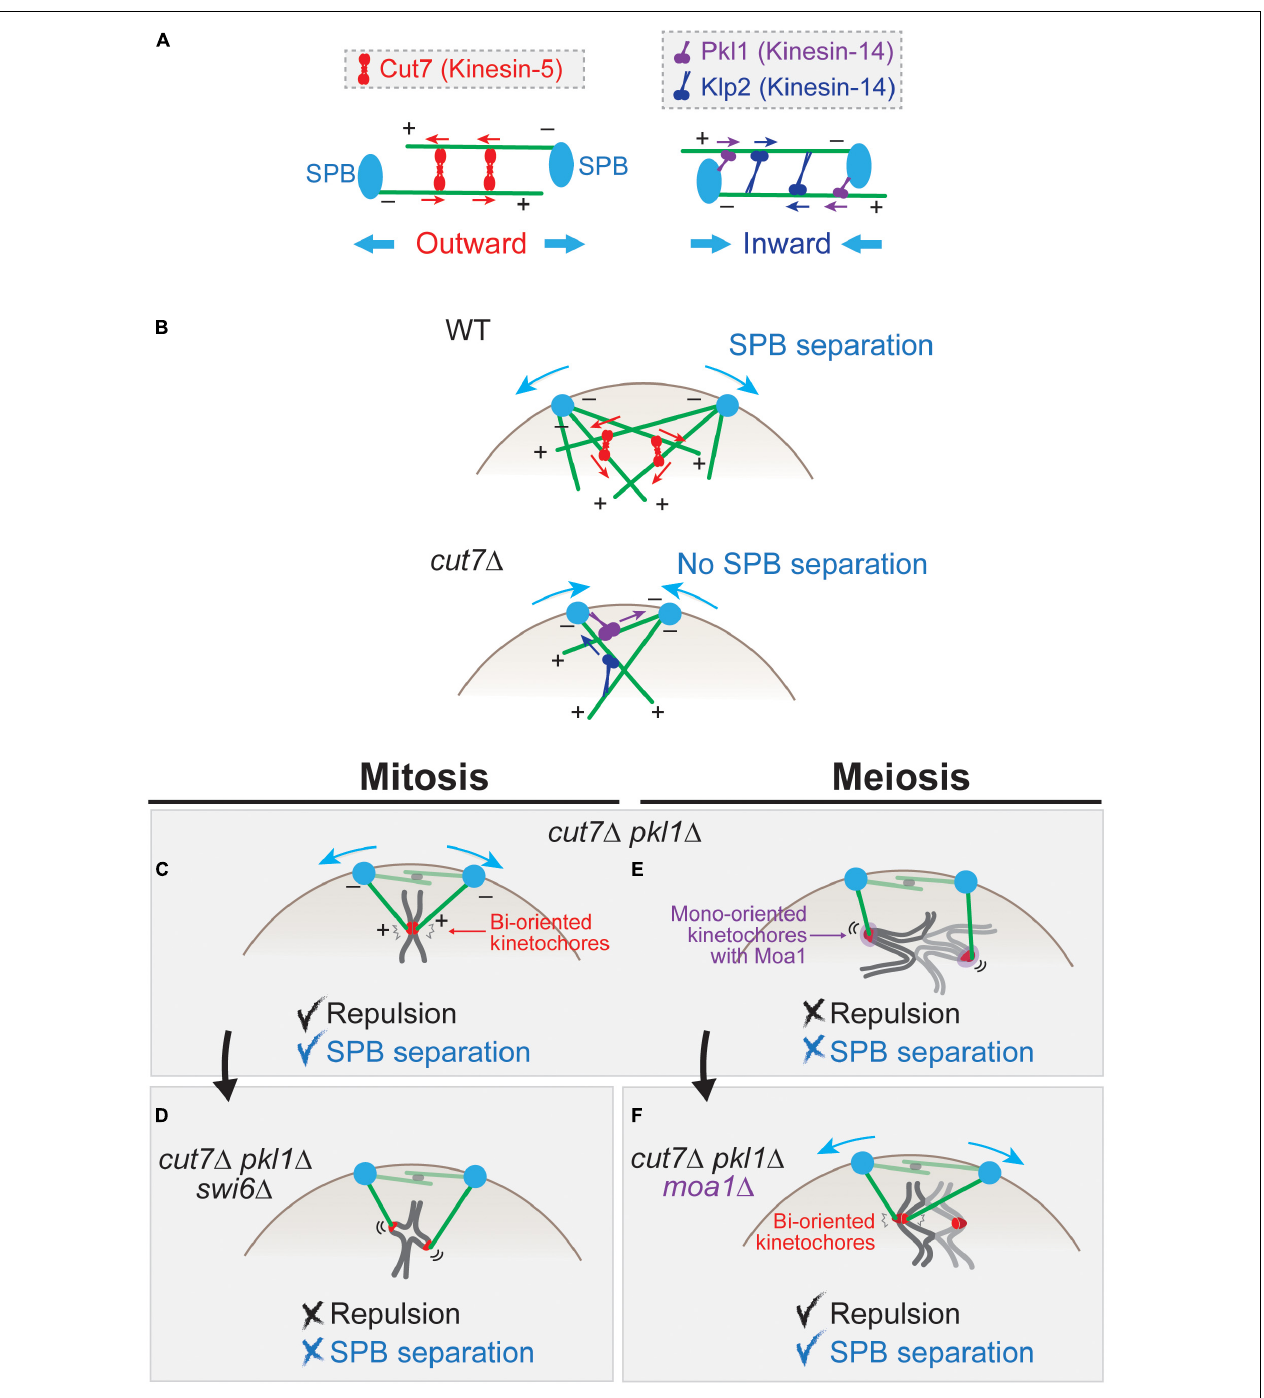
FIGURE 3 | Force balance affects spindle pole body (SPB) separation in mitosis and meiosis. (A) Schematics for functions of Cut7 (kinesin-5) and Pkl1 and Klp2 (kinesin-14) for the inter-SPB distance. A tetramer of Cut7 (red) captures two bundles of microtubules. When they are aligned in an anti-parallel manner, the plus-end-directed Cut7 generates the outward force that consequently separates two SPBs. The polarity of microtubules (+, –) is indicated. Microtubules are tethered to SPBs at their minus ends. Pkl1 localizes to SPBs and Klp2 to the microtubules. Those minus-end-directed motors generate the inward force. (B) SPB separation in prometaphase of mitosis. In wild-type cells, the microtubules nucleated from two SPBs are linked by Cut7 and separate the SPBs. In the cut7 deletion ( cut7 (cid:49) ) mutant, SPBs fail to separate because of the inward force generated by Pkl1 and Klp2. (C) In mitotic cut7 (cid:49) pkl1 (cid:49) cell, SPBs are separated by repulsive forces generated by sister kinetochores. (D) When Swi6 (HP1) is deleted, the structure of sister kinetochores is loosened, which does not generate a sufficient repulsive force to separate SPBs. (E) In contrast to mitosis (C) , cut7 (cid:49) pkl1 (cid:49) cells in meiosis I cannot generate a sufficient repulsive force to separate SPBs. (F) When kinetochores are artificially bi-oriented by depleting Moa1 ( cut7 (cid:49) pkl1 (cid:49) moa1 (cid:49) ), sister kinetochores generate a repulsive force that causes SPB separation.